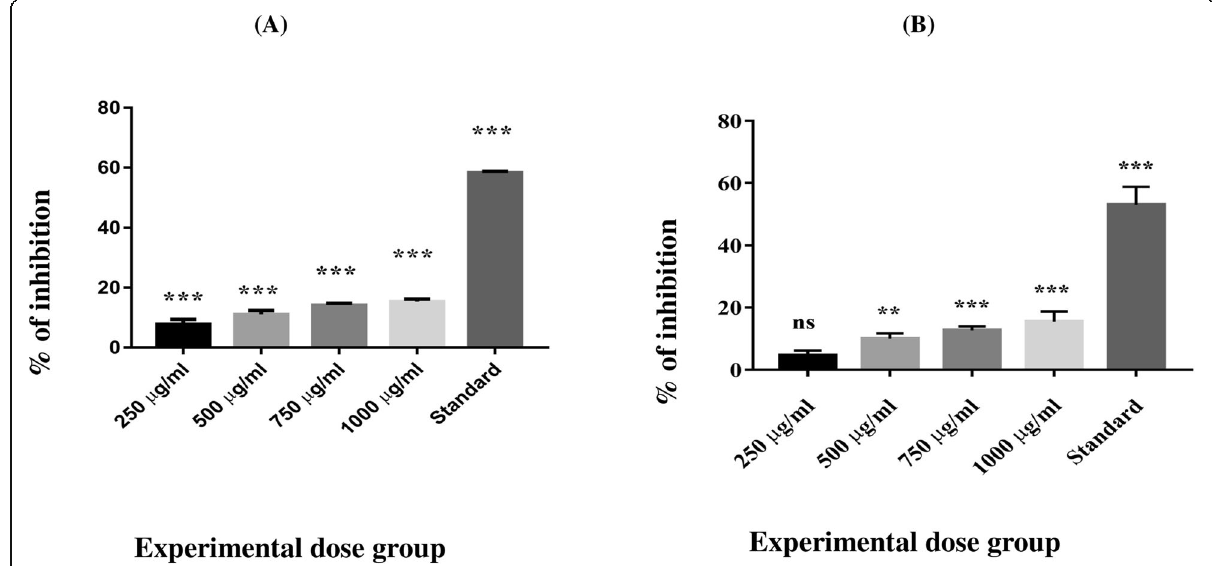
Fig. 3 In vitro anti-inflammatory activity of CML extract. a Heat-induced hemolysis assay and b hypotonicity-induced hemolysis assay where * = p